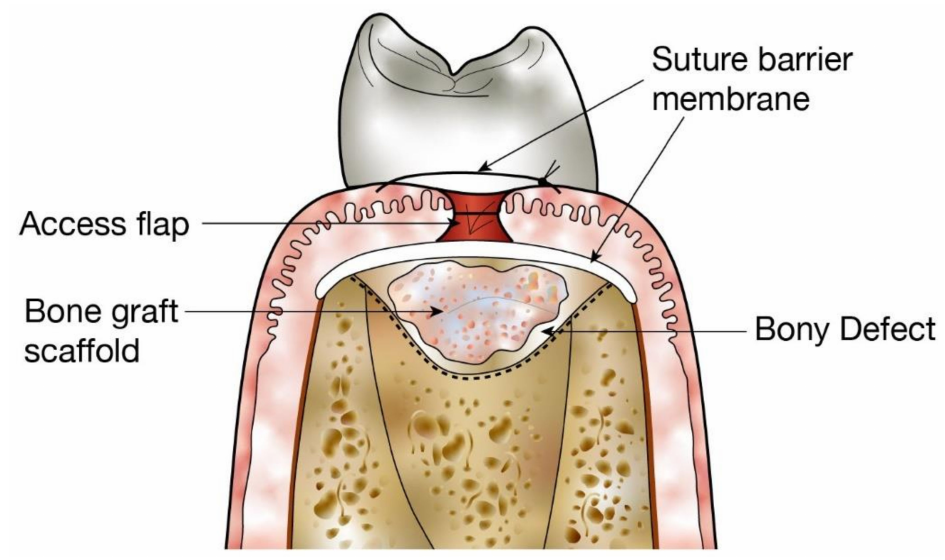
Figure 1. Use of structural scaffolds to restore bony defects. Diagram shows placement of a bone graft scaffold within a bony defect in alveolar bone following surgical generation of an access